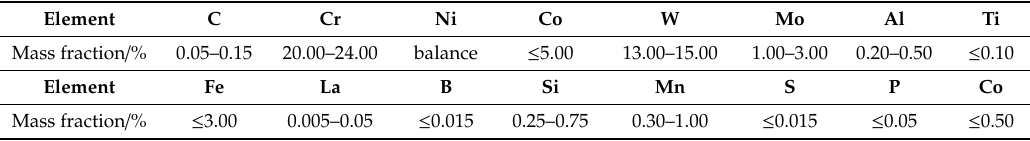
Table 1. Chemical composition of the GH3230 alloy